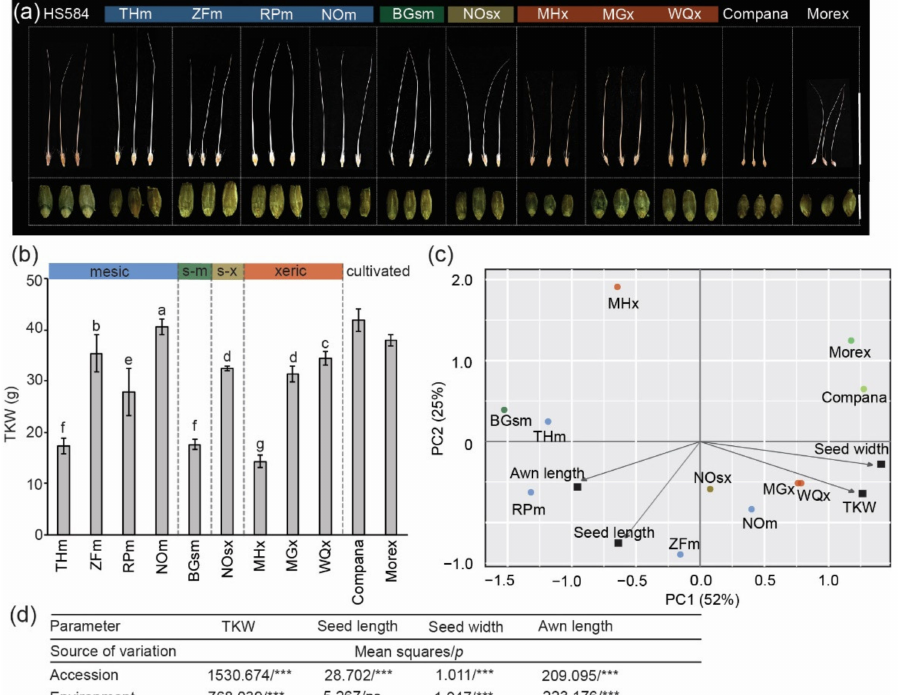
Figure 2. Dry seed phenotypes of wild barley accessions. ( a ) Dorsal views of hulled dry seeds with awns (upper panel; Scale bar = 10 cm) and peeled dry seeds (lower panel; scale bar = 10 mm).